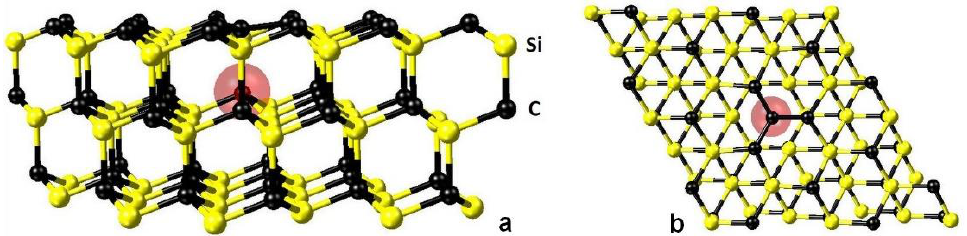
Figure 10. The stable state of a C 4 V silicon vacancy in p-type 3C-SiC (or intrinsic), consisting of an almost flat cluster of 4 C atoms and a void shown as a semi-transparent red sphere. ( a )—view in the direction <011>, ( b )—view in the direction <100>.